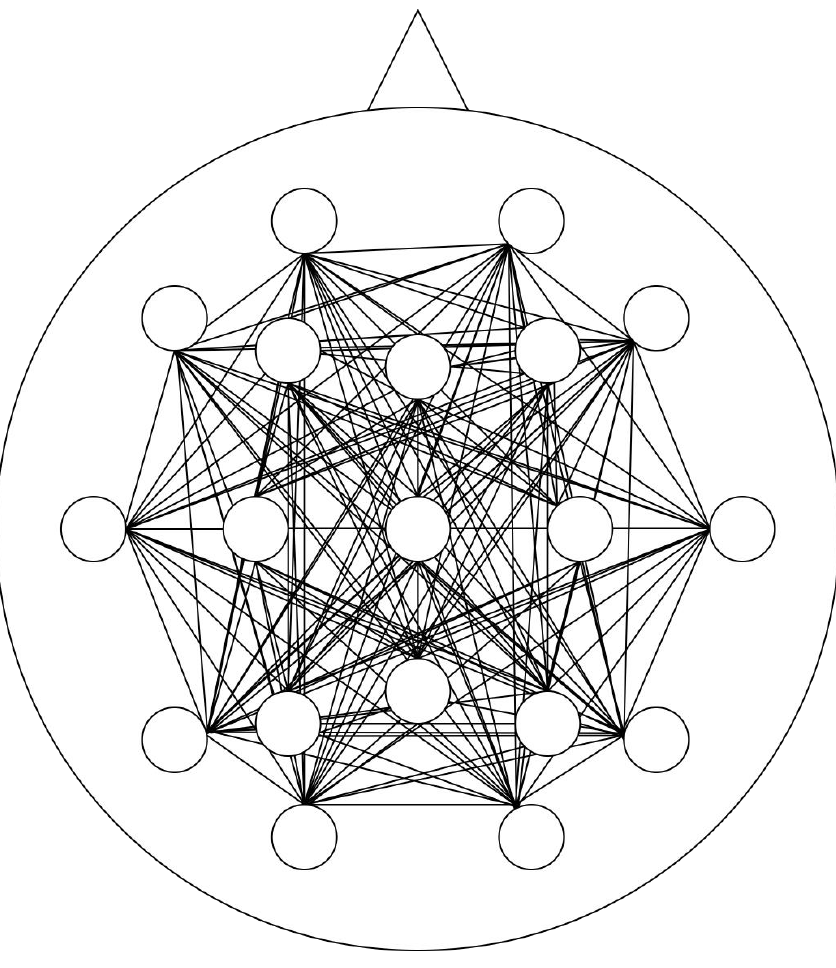
Figure 1. Schematic diagram of the brain’s complex network (full